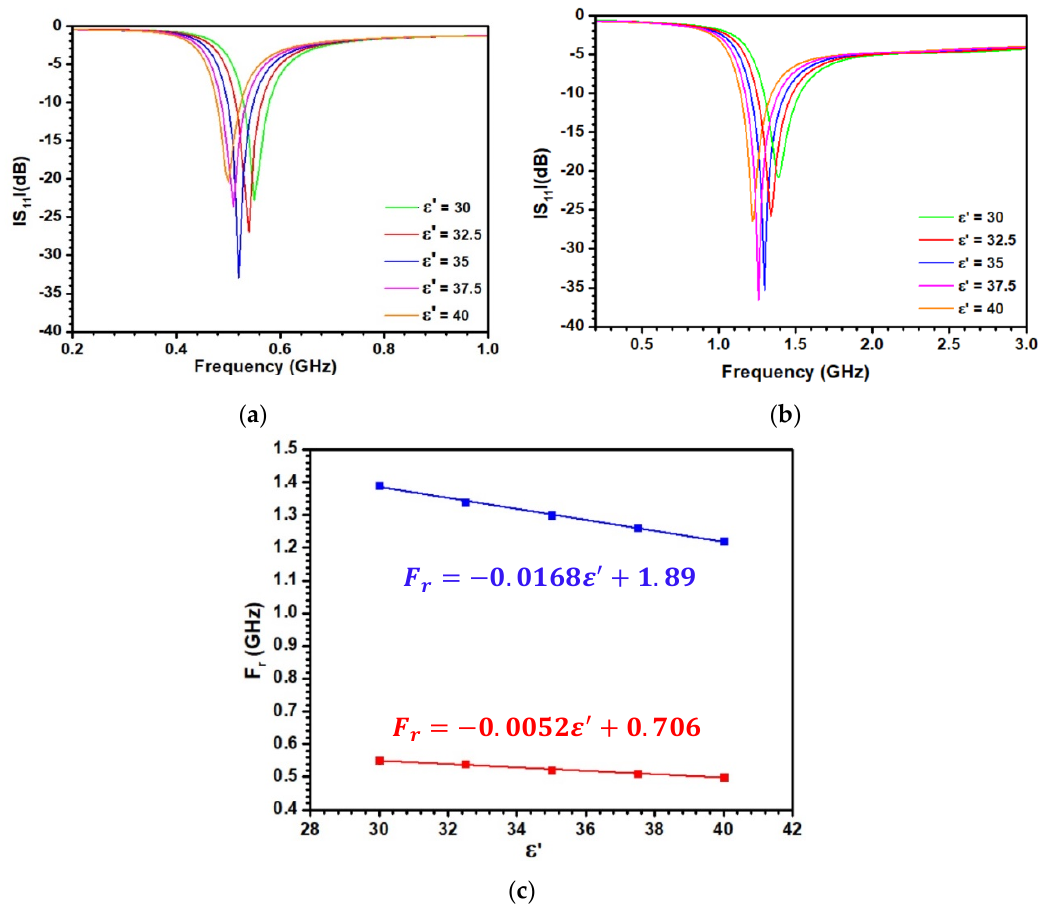
Figure 6. (a) Variation of the S 11 parameter as a function of frequency for different permittivity values. Figure 6. ( a ) Variation of the S 11 parameter as a function of frequency for di ff erent permittivity values.